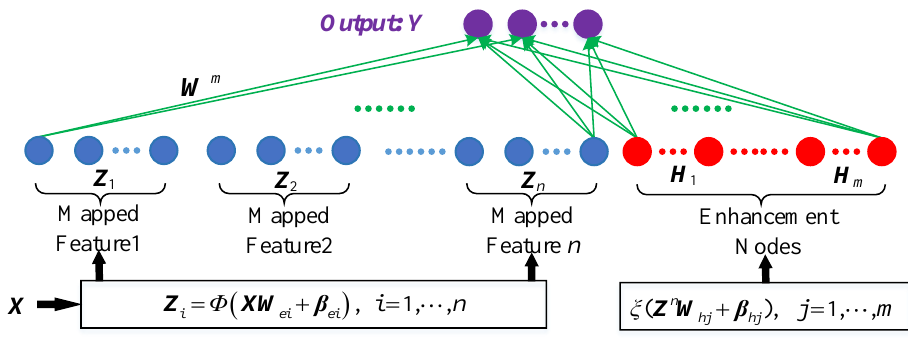
Figure 1. Structure of the broad learning system. Assuming that the BLS network sets n mapped features and each mapped feature is equipped with k nodes, the i -th mapped feature Z i can be represented as in Equation (6):